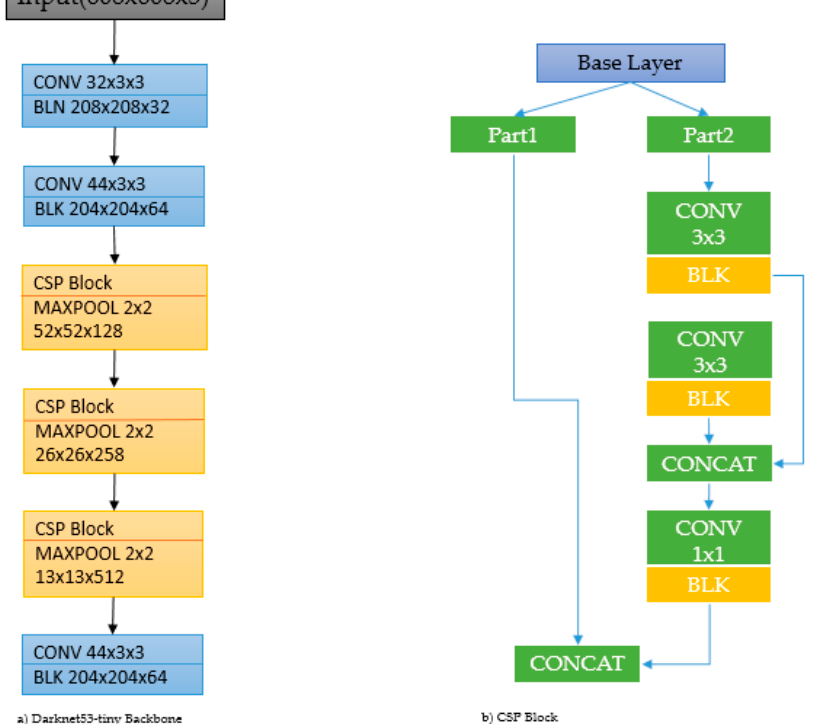
Figure 3. Backbone of original YOLOv4-tiny. Left side: Darknet53-tiny backbone architecture. Right side: CSP block.